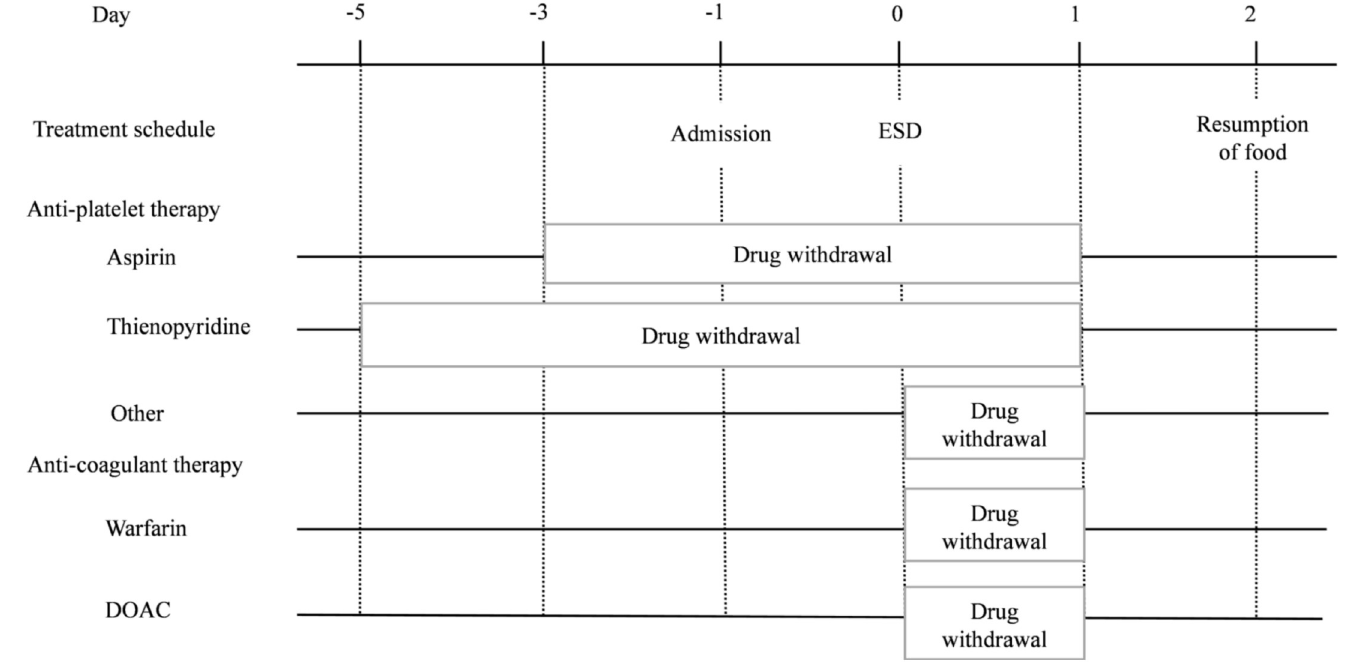
Fig 3. The withdrawal schedules of each antithrombotic drug in the observational study. ESD, Endoscopic submucosal dissection.